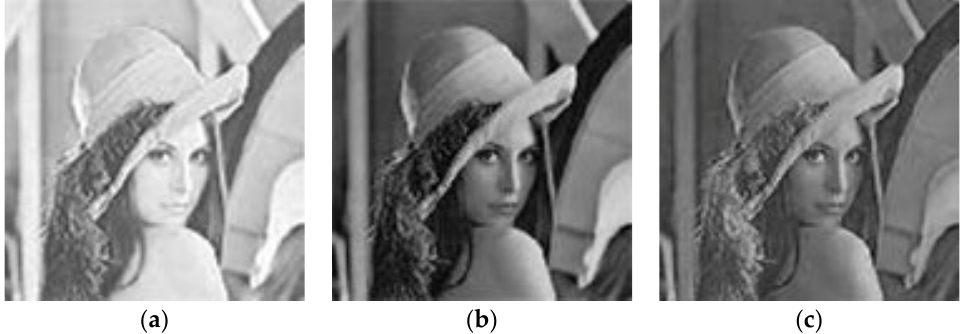
Figure 2. RGB ‐ channel image of Lena: ( a ) original plaintext, R ‐ channel image; ( b ) original plaintext, G ‐ channel image; ( c ) plaintext, B ‐ channel image.